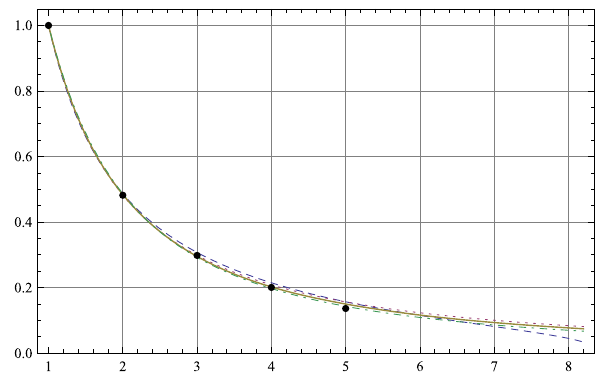
Fig. 4 Jet functions fitted to Eq. (26) with LO ˜ J in in the ranges N = 1- 3 (dotted line), N = 1-4 (solid line), and N = 1-5 (dash-dotted line), where the horizontal (vertical) axis is labelled by N ( ˜ J ( N ) ). The exact N